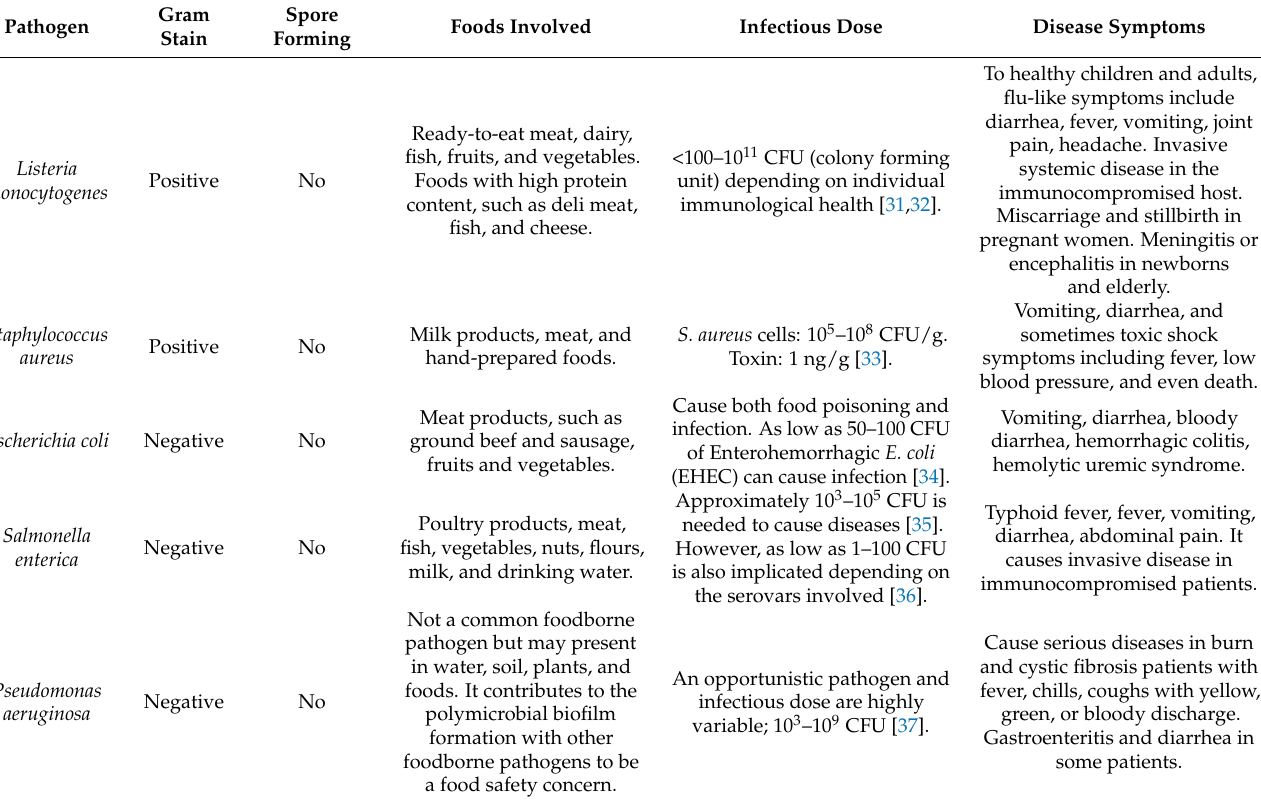
Table 1. Summary of foodborne pathogens and their implication in food